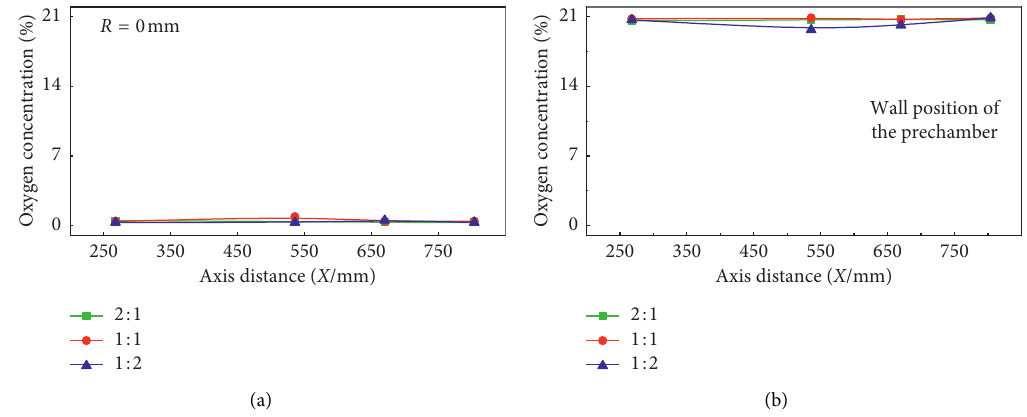
Figure 7: O 2 concentration profiles along axis distance for different